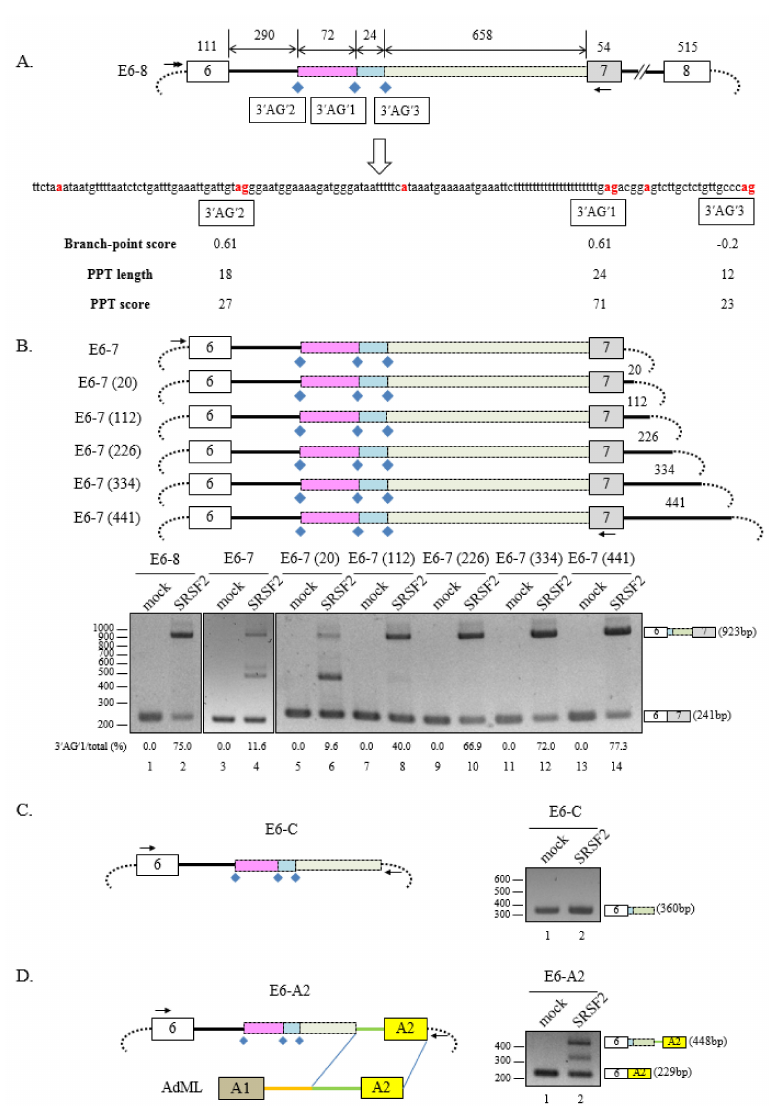
Figure 1. The serine / arginine rich splicing factor 2 (SRSF2) promotes cryptic 3 (cid:48) AG (cid:48) splice-site activation. ( A ) Schematic diagram of the E6-8 minigene. Exons are depicted as numbered gray and white boxes, introns as solid lines, vector sequence as dots and acryptic 3 (cid:48) AG (cid:48) sites as blue diamonds. The 3 (cid:48) AG (cid:48) 1, 3 (cid:48) AG (cid:48) 2 3 (cid:48) AG (cid:48) 3 and associated sequences are shown below the schematic diagram. The fragment from 3 (cid:48) AG (cid:48) 3 to the end of intron 6 is indicated in light green, the fragment from 3 (cid:48) AG (cid:48) 1 to 3 (cid:48) AG (cid:48) 3 is indicated in cyan, and the fragment between 3 (cid:48) AG (cid:48) 2 and 3 (cid:48) AG (cid:48) 1 is indicated in pink. Additionally, the 3 (cid:48) AG (cid:48) sequence and BP (cid:48) adenosine are highlighted in red, the primer binding sites used for RT-PCR reaction are indicated as arrows, and BP scores, PPT length, and PPT scores of each 3 (cid:48) AG (cid:48) s are shown. ( B ) (Upper panel) Schematic diagram of the E6-7 minigene and various constructs. The primer bindings sites used for RT-PCR analysis are indicated as arrows. (Lower panel) RT-PCR analysis of intron 6 splicing within the E6-8, E6-7 minigene or various mutant constructs using RNAs extracted fromSRSF2-expressing or pcDNA transfected cells. The sizes of products are shown at the right of all figures here and below. ( C ) (Left panel) Schematic diagram of the E6-C minigene indicating primer binding sites. (Right panel) RT-PCR analysis of the E6-C minigene using RNAs extracted from SRSF2-expressing or pcDNA transfected cells. ( D ) (Left panel) Schematic diagram of the E6-A2 and AdML minigenes indicating primer binding sites. (Right panel) RT-PCR analysis of intron splicing within the E6-A2 minigene in pcDNA- or SRSF2-expressing